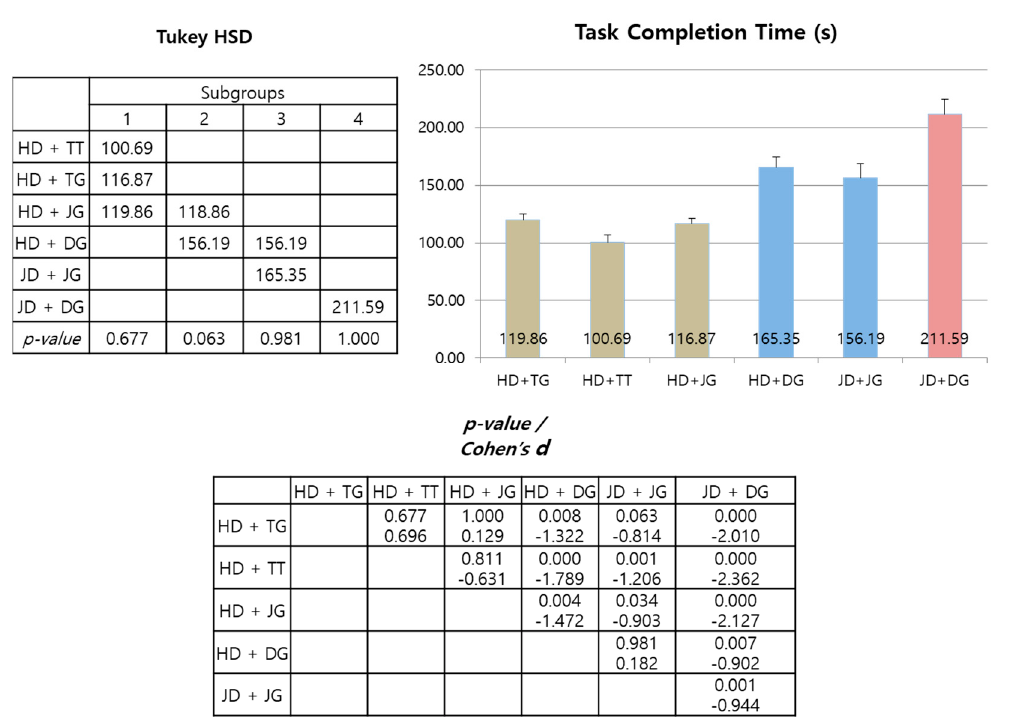
Figure 8. The average task completion times among the six tested interfaces.